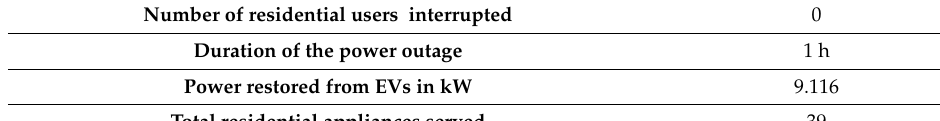
Table 5. Status of the test system during the outage with EVs.